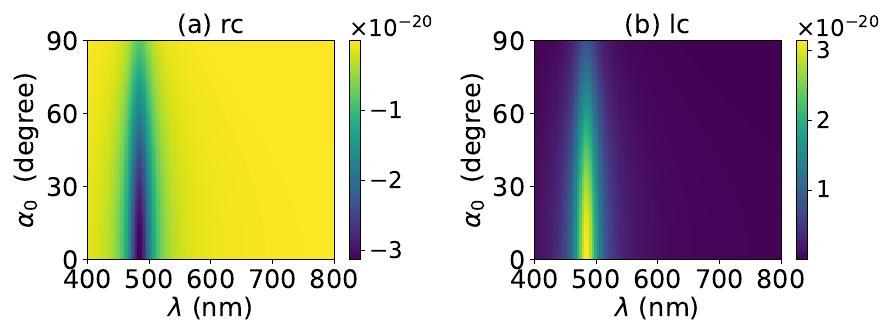
Figure 20. The axial optical torque T z of a zeroth-order Bessel beam centered on a graphene-coated gold nanosphere. The layer number is N = 0, which means the particle is a gold nanosphere without graphene coating. Panels ( a – f ) correspond to linear, circular, radial, and azimuthal polarizations, respectively.